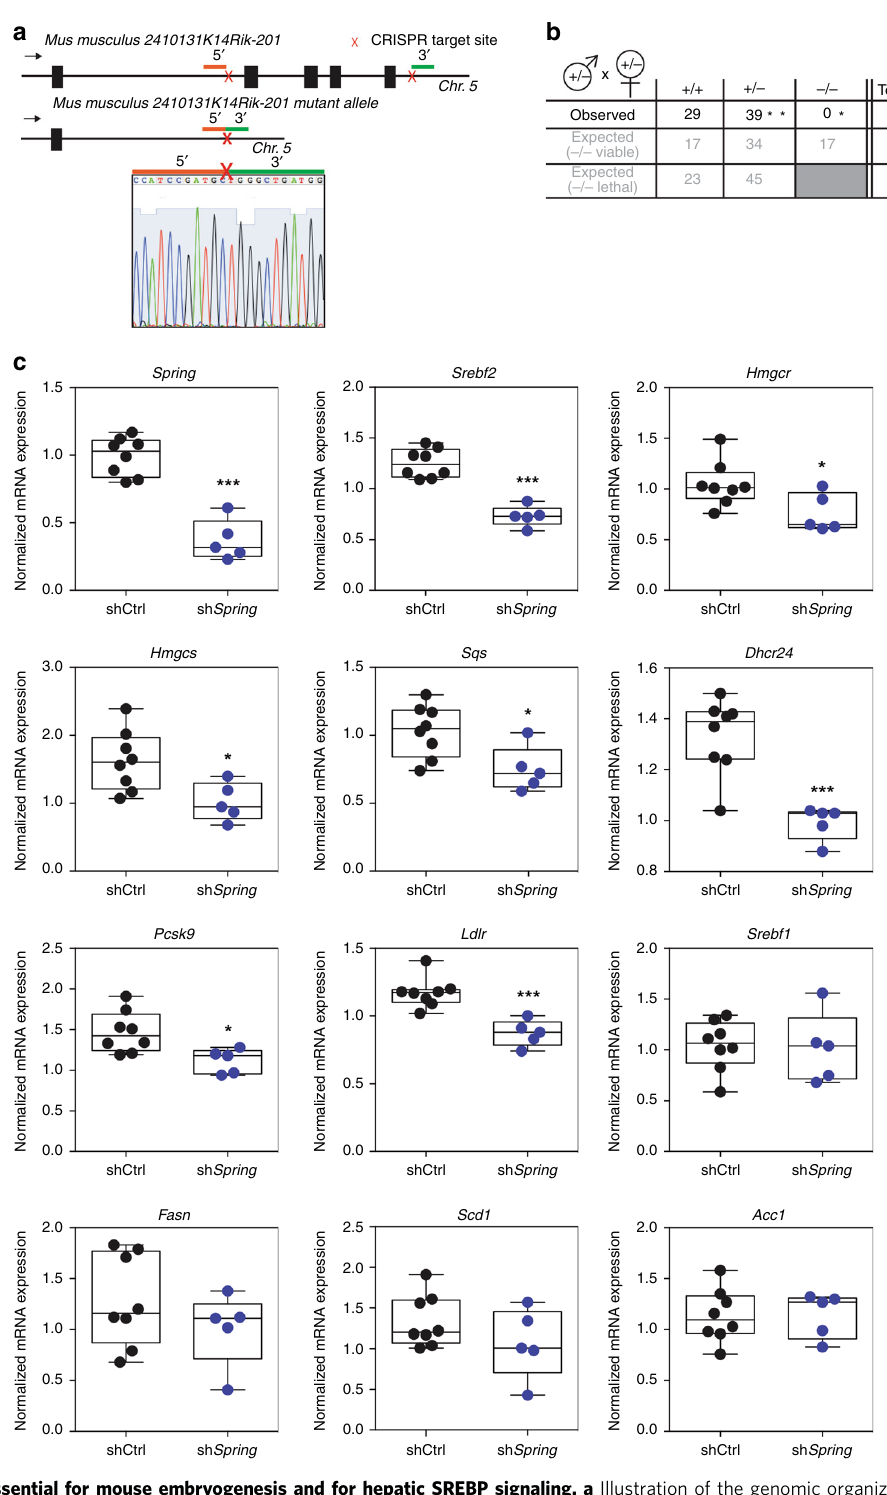
Fig. 4 SPRING is essential for mouse embryogenesis and for hepatic SREBP signaling. a Illustration of the genomic organization of murine SPRING (2410131K14Rik-201) and the allele obtained after CRISPR/Cas9 editing. The 5 ’ and 3 ’ gRNAs are indicated in red and green, respectively. Sanger sequencing of ampli fi ed genomic DNA was performed to con fi rm the deletion of exons 2 – 5. b Table showing an overview of the obtained genotypes from various crosses of heterozygous mice. * p < 0,005, lower than expected by Pearson ’ s Chi-square test with 2 df; **equal to expected when assuming embryonic lethality of homozygous null mice, Chi-square = 2.37, 0.9 > p > 0.1 with 1 df. c WT C57BL/6J mice were administered Ad-shCtrl or Ad-sh Spring ( N = 8/5 animals per group, respectively) via tail-vein injection. After 7 days, mice were fasted overnight and subsequently refed for 6 h. Total liver RNA was isolated and expression of the indicated genes was determined by qPCR. Each individual mouse is plotted within the box and whiskers plot that depicts the median line, the 25th and 75th percentile, and the min-max values. * p < 0.05, *** p <